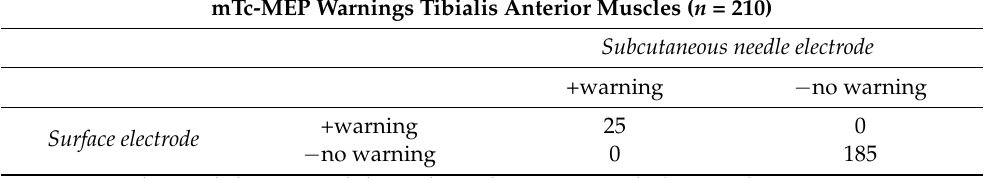
Table 3. The number of patients with an mTc-MEP warning in the left and/or right TA for both surface and subcutaneous needle recording